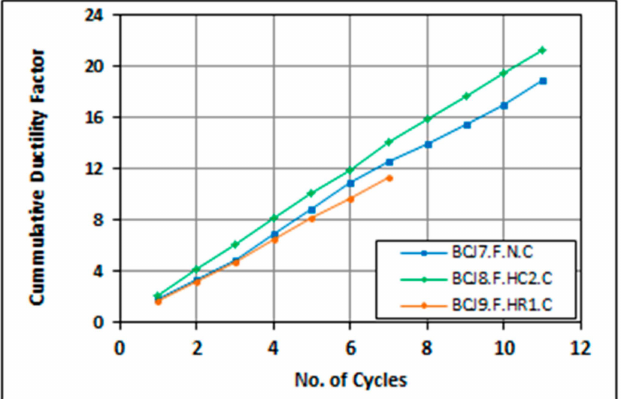
Figure 8. Variation of cumulative ductility factor of specimens subjected to cyclic